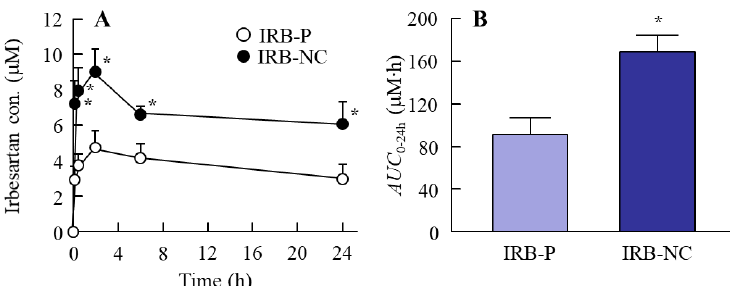
Figure 5. Changes in the plasma irbesartan concentration in the rats orally administered the IRB-P and IRB-NC suspensions. ( A , B ) The absorption profile ( A ) and AUC 0–24h ( B ) of irbesartan in the IRB-P and IRB-NC suspensions. IRB-P, IRB-P-suspension-administered rats. IRB-NC, IRB-NC-suspension-administered rats. n = 7. * p < 0.05 vs. IRB-P for each category. The intestinal absorption of irbesartan in the IRB-NC suspensions was significantly higher than that in the IRB-P suspensions.